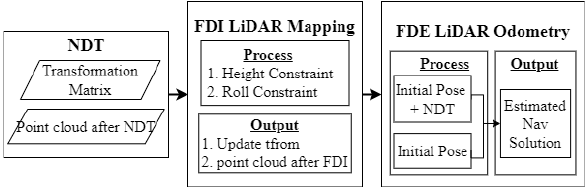
Figure 5 . FDIE strategy application.